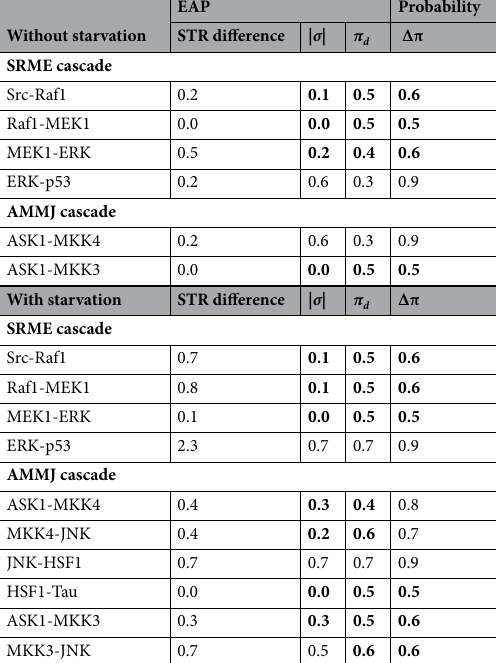
Table 1. Statistics of the expected a posteriori STR difference. EAP, expected a posteriori, is an alternative to the mean in classical statistics. A–B represents the difference between steps A and B in the cascade shown in the left column. “STR difference” represents the difference between STR of A (STR(A)) and STR of (STR(B)). σ = Δμ (A − B)/ δ (A) represents the effect size, where Δμ (A − B) represents the EAP difference between STR(A) and STR(B), and δ (A) represents the posterior standard deviation of STR(A). Values in the upper column “EAP” represent the EAP values of the STR difference, | σ |, and π d . The value under “Probability” Δπ in the upper column represents the larger probabilities of Δμ (A − B) and Δμ (B − A) (the closer the two STRs, the closer the value to 0.5). Bold letters indicate the STR differences that satisfy